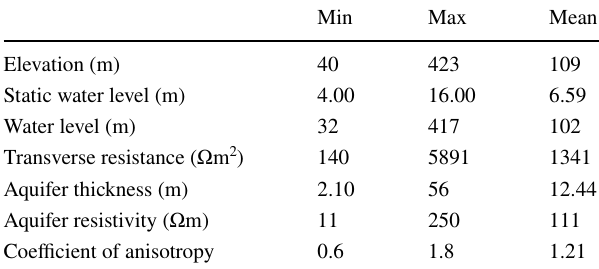
Fig. 4 Flowchart showing the methods used for the study Table 2 Summary of aquifer parameters obtained from geo-electrical and hydrogeological